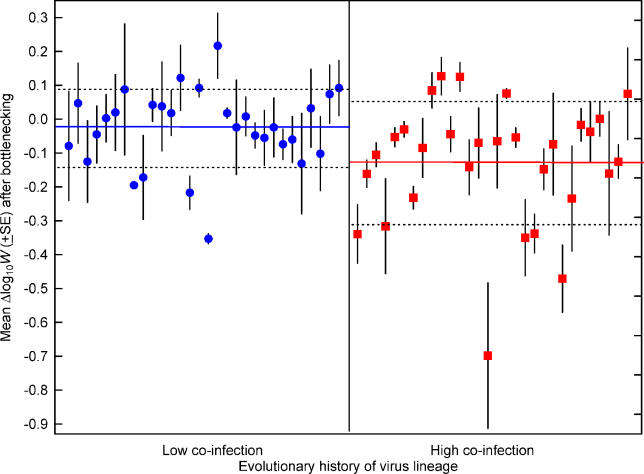
Viruses Evolved under Low Co-Infection Are More Robust than Those Evolved under High Co-InfectionEach point is the mean (n = 3, ± standard error of the mean) change in log10 fitness (Δlog10
W) resulting from mutation accumulation, for an independent lineage founded by a virus clone evolved under low level of co-infection (circles) or high level of co-infection (squares). Horizontal lines are grand means for Δlog10
W among lineages within a treatment, and the dashed lines indicate one standard deviation away from the grand mean.